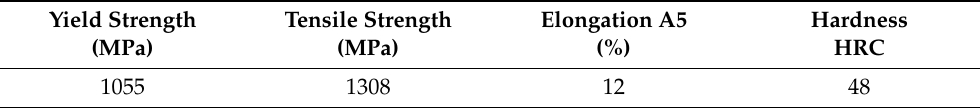
Table 4. Mechanical properties of the cladding wire Diavar by